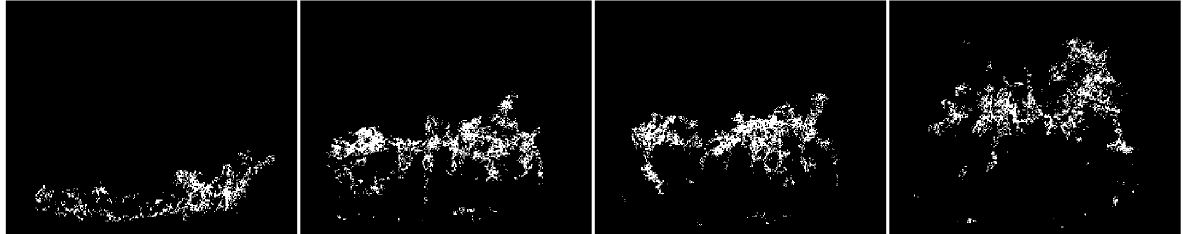
Figure 5. Regions from the frames in the top row of Figure 2 that are part of the active combustion zone. The RGB value of ( 255,181,147 ) is sampled from a pixel that is known to be in the combustion region. After experimenting with different tolerances for a single frame, tolerances of 15 (R), 60 (G), and 40 (B) are chosen, and these are used to define actively combusting pixels in every frame.